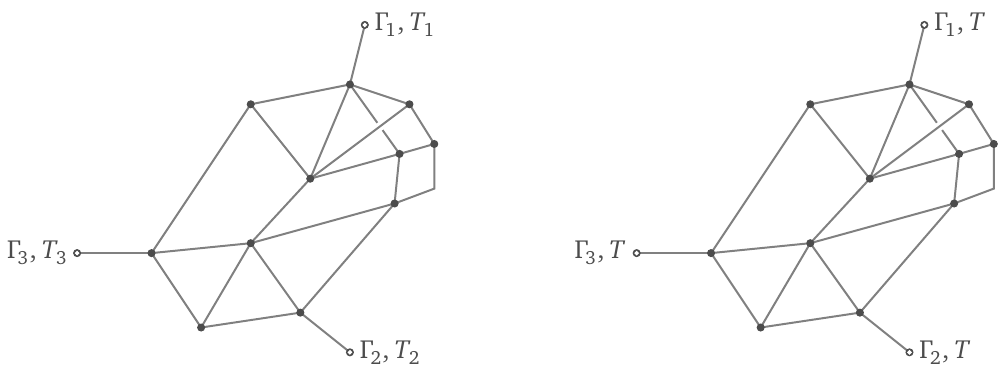
Figure 1: A probability distribution in the system of the left is mapped onto one in the system of the right. The mapping is preserved by subsequent evolution and may be inverted. The stationary state attained in the system of the left is mapped onto the equilibrium state of the system to the right. The couplings to the reservoirs Γ remain the i